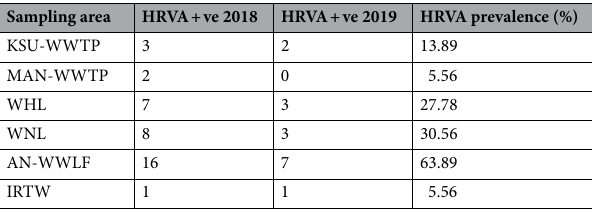
Table 1. HRVA prevalence in different sample